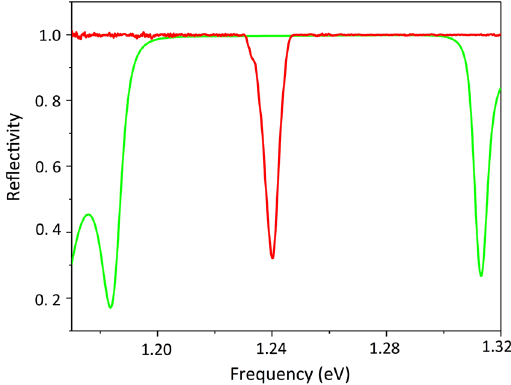
Figure 6. The reflection spectra of the Bragg reflector (green), before deposition of the silver layer, and the Tamm plasmon microcavity (red).